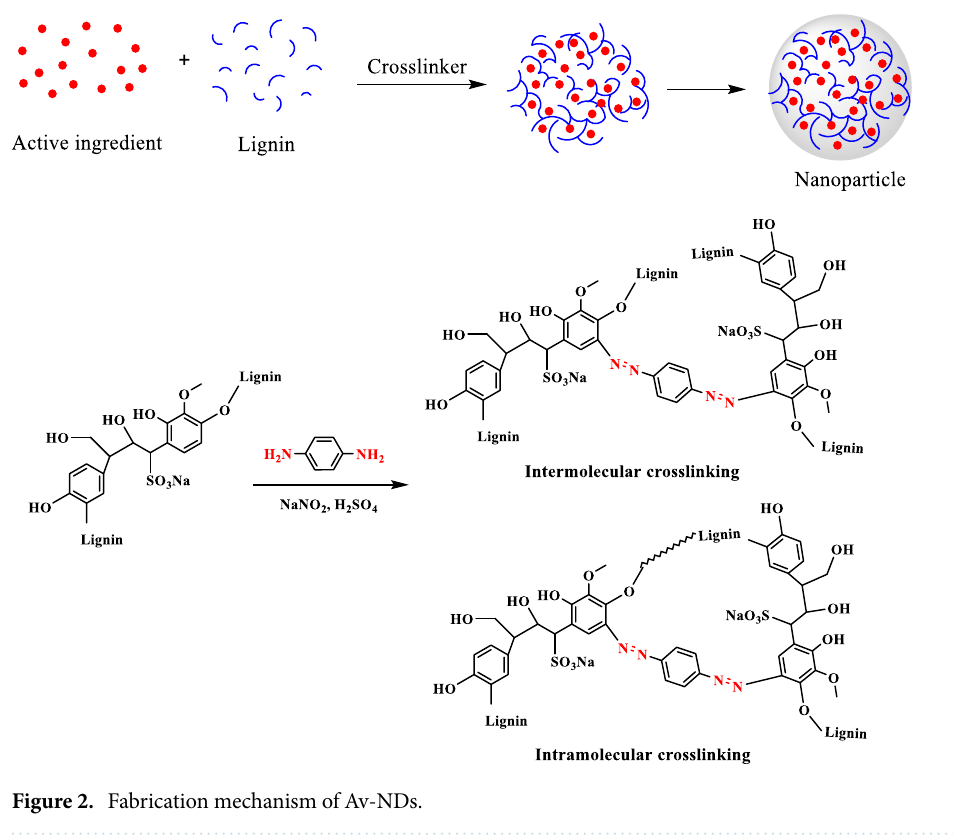
Figure 2. Fabrication mechanism of